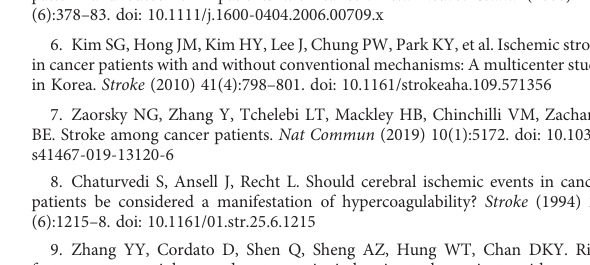
SUPPLEMENTARY FIGURE 3 GO term of biological process enrichment with intersected genes in each group (Top 20 of terms). (BC: control group for uninjured brain; B2B and B6B: brain samples group for the 2 nd or 6 th day after brain PT; SC: control group for uninjured skull; S2S and S4S: skull samples group for the 2 nd or 4 th day after skull PT; B2S and B6S: skull samples group for the 2 nd or 6 th day after brain PT; S2B and S4B: brain samples group for the 2 nd or 4 th day after skull PT) SUPPLEMENTARY TABLE 1 Differential expression genes for each group. SUPPLEMENTARY TABLE 2 GO biological process enrichment for up- and down-regulated genes. SUPPLEMENTARY TABLE 3 GSVA score of cancer hallmarks for each sample. SUPPLEMENTARY TABLE 4 Estimated immune cell abundances for each